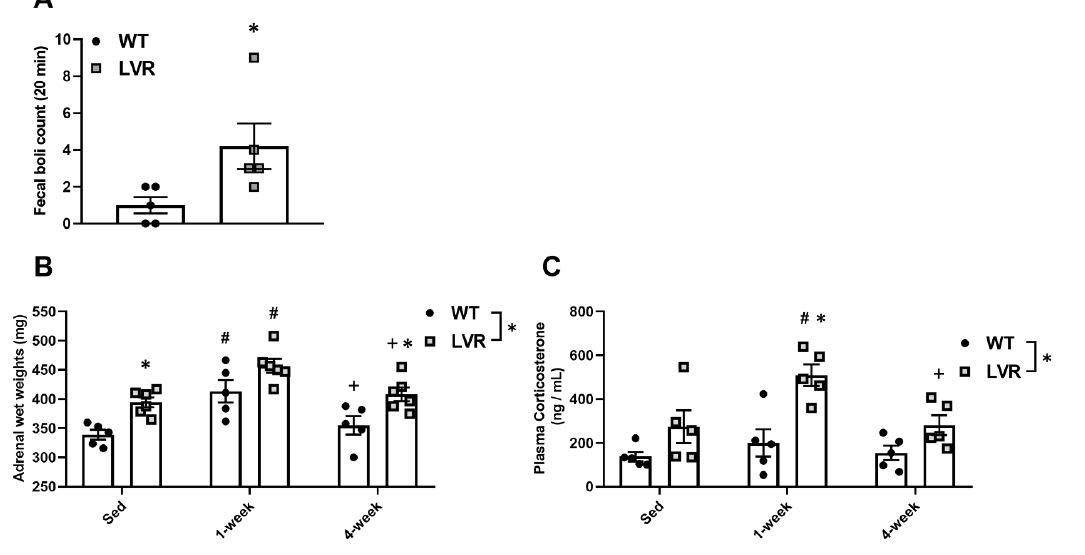
Figure 2. Differences in markers of stress-reactivity and HPA activity between WT (n = 5; closed circles) and LVR (n = 5–6; gray squares) rats. ( A ) Fecal boli counts following 20-min exposure to a novel environment under sedentary conditions. ( B ) Adrenal wet weights under sedentary, 1 week and 4 week wheel-running conditions (mg). ( C ) Plasma corticosterone levels under sedentary, 1week and 4 week wheel-running conditions (ng/mL). * Denotes main effect of strain and post-hoc differences ( p < 0.05) between groups within timepoint. # post-hoc difference ( p < 0.05) relative to within group sedentary animals. + post-hoc difference 4 weeks vs. 1 week within group ( p < 0.05). Values shown as mean ± SE.